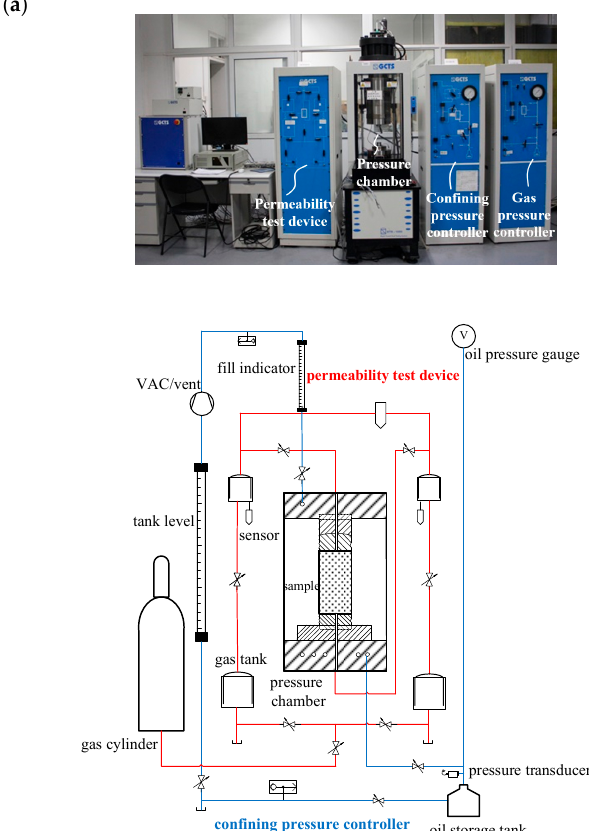
Figure 2. ( a ) Test system and ( b ) schematic diagram of permeability measure in the process of triaxial test.